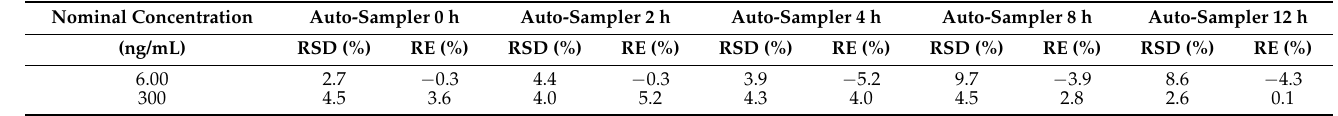
Table 2. Stability of physalin A stored in auto-sampler before LC–MS/MS analysis. Nominal